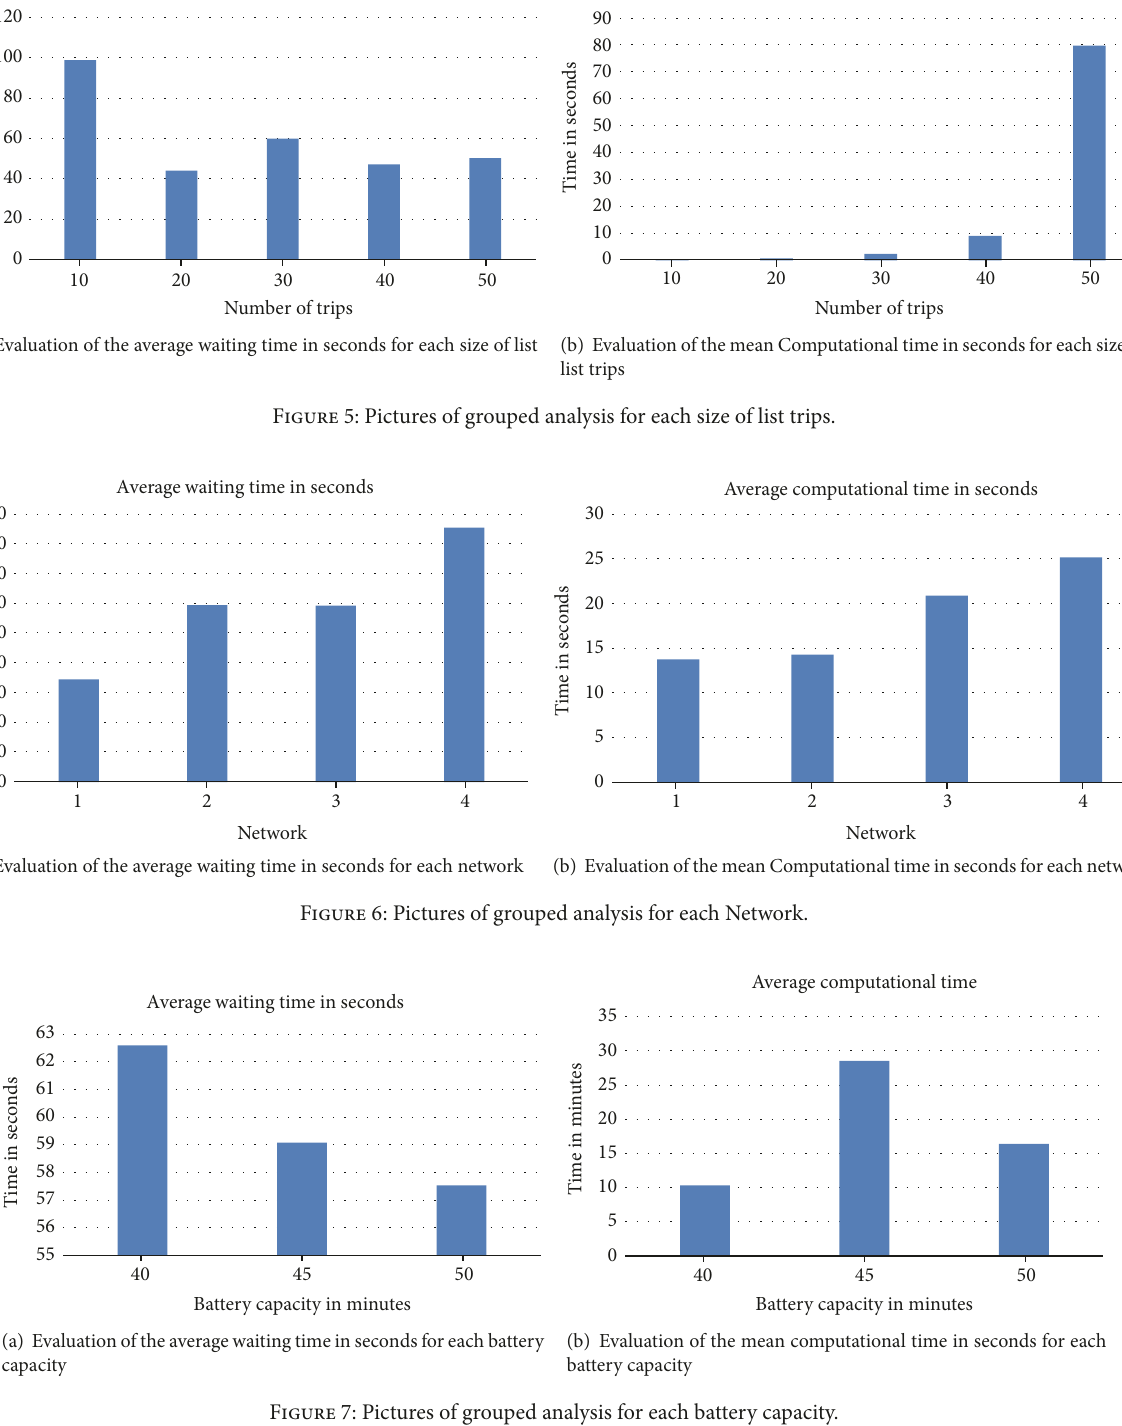
Figure 7: Pictures of grouped analysis for each battery